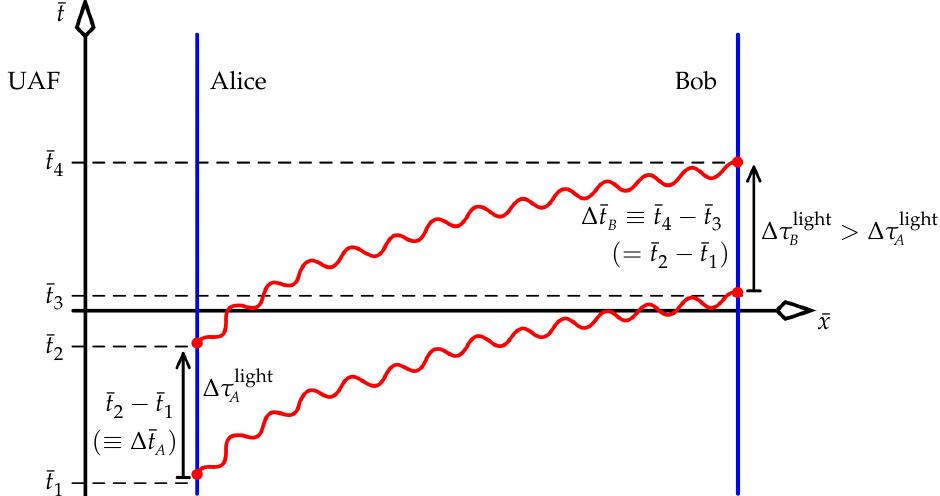
Figure 8. The scenario of Figure 6 represented in the UAF’s barred coordinates. The light rays’ world lines are drawn curved because the coordinate speed of light is proportional to ¯ x , as in (35). Note that, although ¯ t 2 − ¯ t 1 and ∆ τ light both refer to the time separation of the two emissions of the rays, they A are not necessarily equal; the first is coordinate time and the second is proper time. The same can be said for ¯ t 4 − ¯ t 3 and ∆ τ light B